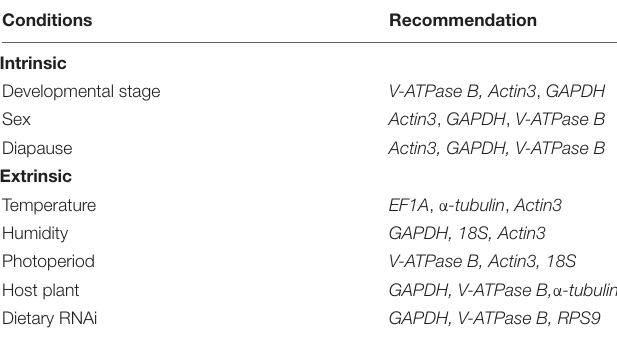
TABLE 3 | Recommended reference genes under different intrinsic and extrinsic